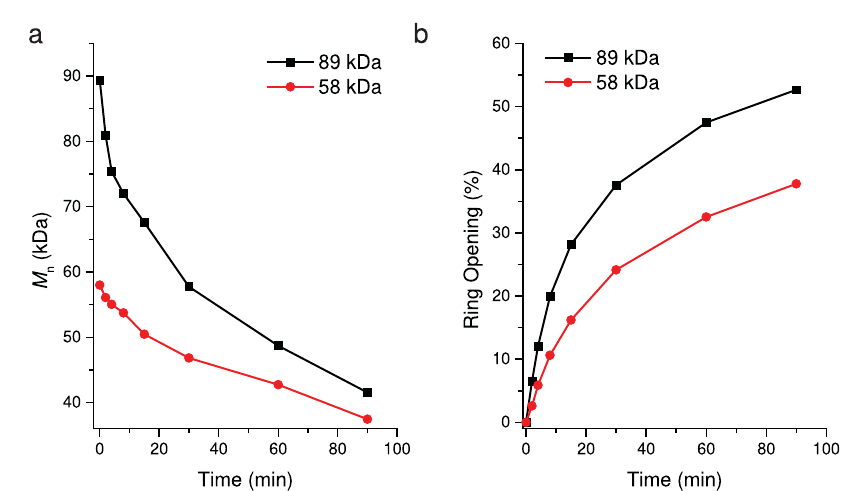
Fig. 5 | Kinetic study of sonication. Number-average molecular weight ( M n ) ( a ) and percentage of ring opening ( b ) as a function of sonication time for P1 with two different initial molecular weights (89kDa, in black; 58kDa, in red).